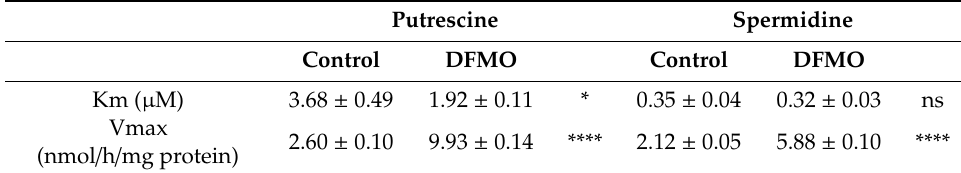
Table 3. Kinetic parameters of the uptake transporter.